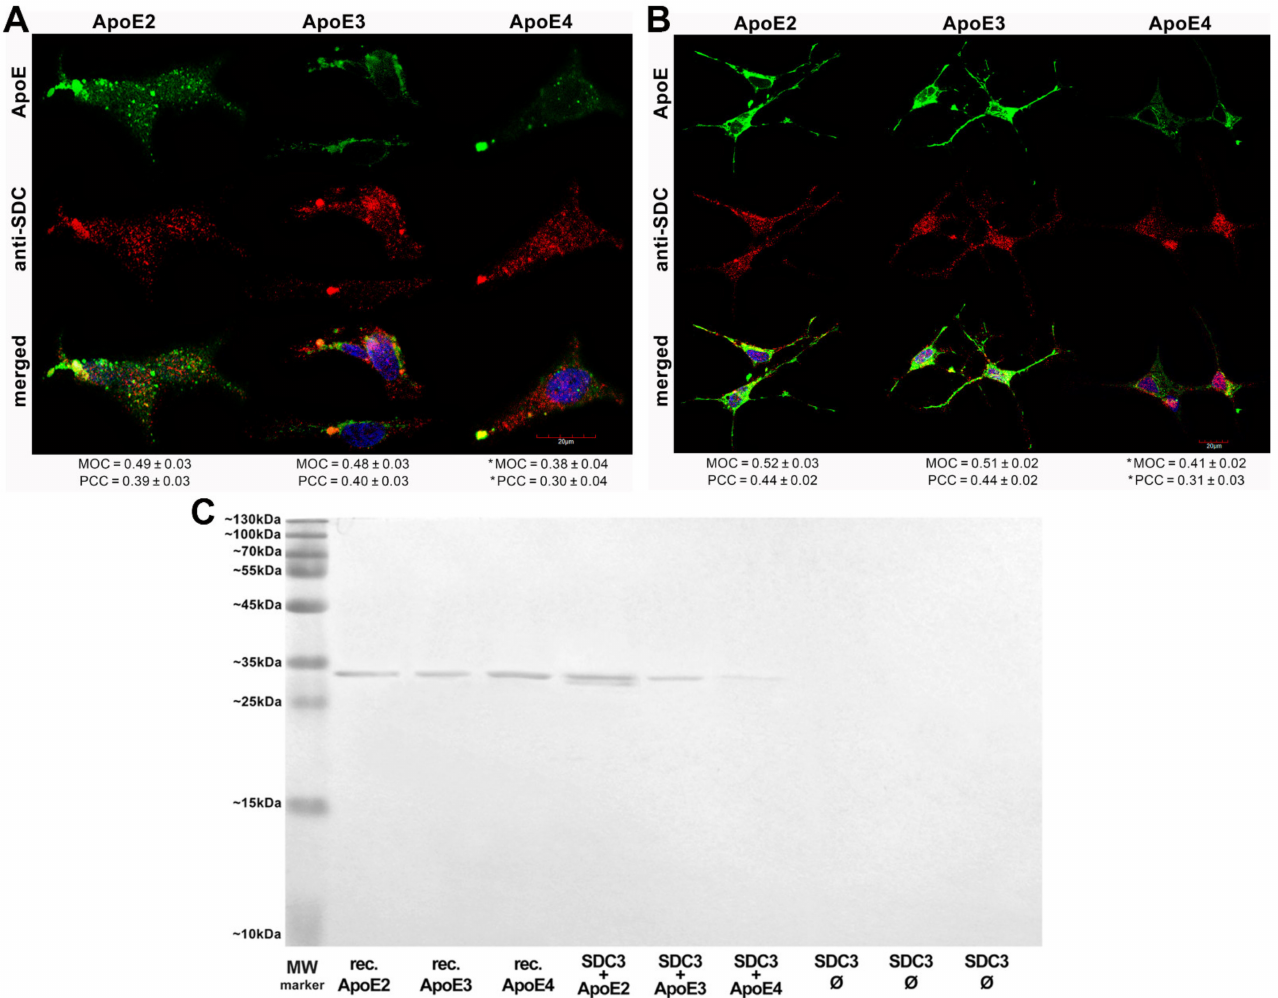
Figure 3. Colocalization of ApoEs with SDC3 in SH-SY5Y cells. ( A , B ) Undifferentiated ( A ) or differentiated ( B ) SH-SY5Y cells were treated with either of the FITC-ApoEs for 3 h at 37 ◦ C. After incubation, the cells were permeabilized and treated with the APC-labeled SDC3 antibody. Nuclei of cells were stained with DAPI and colocalization was then analyzed with confocal microscopy. Representative images of three independent experiments are shown. Scale bar = 20 µ m. MOCand PCC ± SEM, for the colocalization of SDCs with FITC-ApoEs, was calculated by analyzing 21 images with ~7 cells in each image (from three separate samples). ( C ) SDS-PAGE showing FITC-labeled ApoEs immunoprecipitated with SDC3 from extracts of differentiated SH-SY5Y. Lane 1: MW marker. Lanes 2–4: 0.5 µ g of FITC-ApoE2,3 and 4, respectively. Lanes 5–7: immunoprecipitate of SH-SY5Y cells treated with either of the FITC-ApoEs. Lanes 8–10: immunoprecipitate of untreated SH-SY5Y cells. Standard protein size markers are indicated on the left. Image acquisition was carried out with UVITEC Alliance Q9 Advanced